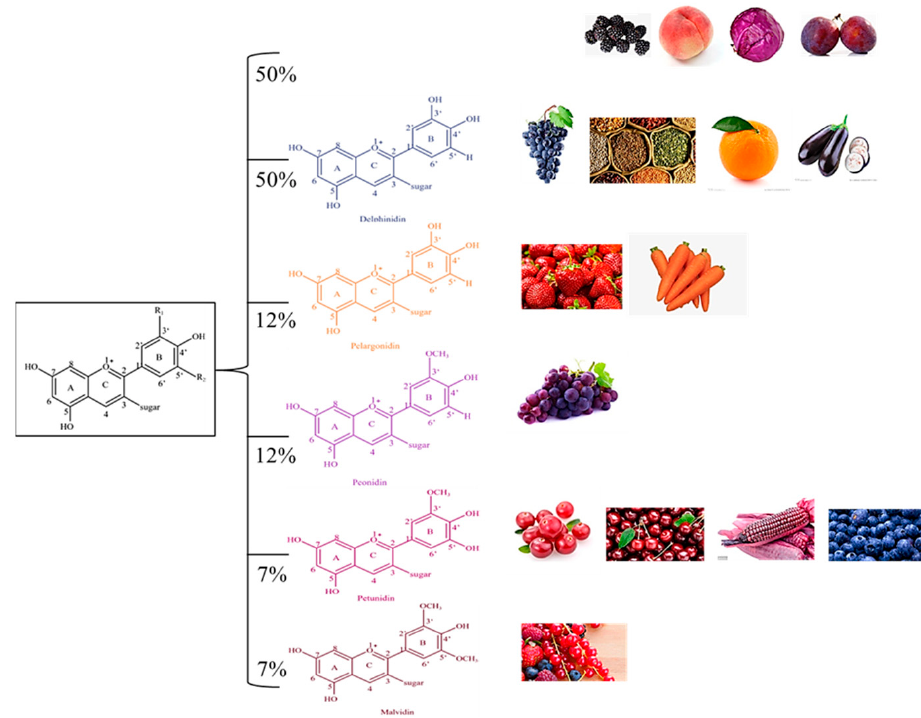
Figure 1. The structure and composition of natural anthocyanins.